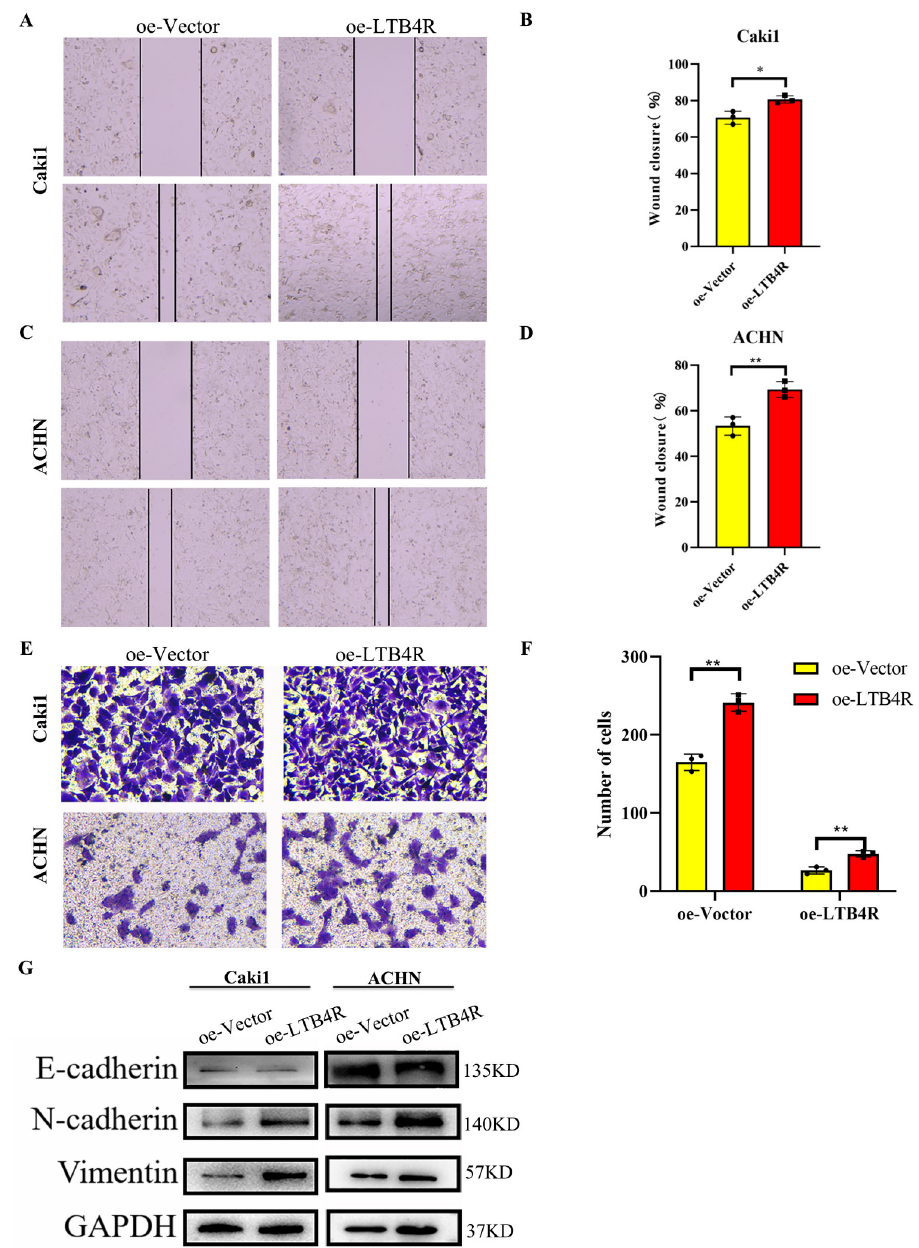
Figure 6. Overexpression of LTB4R promoted the migration, invasion and EMT process of ccRCC cells. ( A – D ) Overexpression of LTB4R promoted the migratory ability of Caki1 and ACHN cells. ( E , F ) Overexpression of LTB4R promoted the clonogenicity of Caki1 and ACHN cells. ( G ) Western blot Analysis showed that overexpression of LTB4R significantly decreased the epithelial phenotype E-cadherin and increased mesenchymal phenotype (N-cadherin, Vimentin) of Caki1 and ACHN cells. A 2-tailed t test was used (* p < 0.05, ** p <